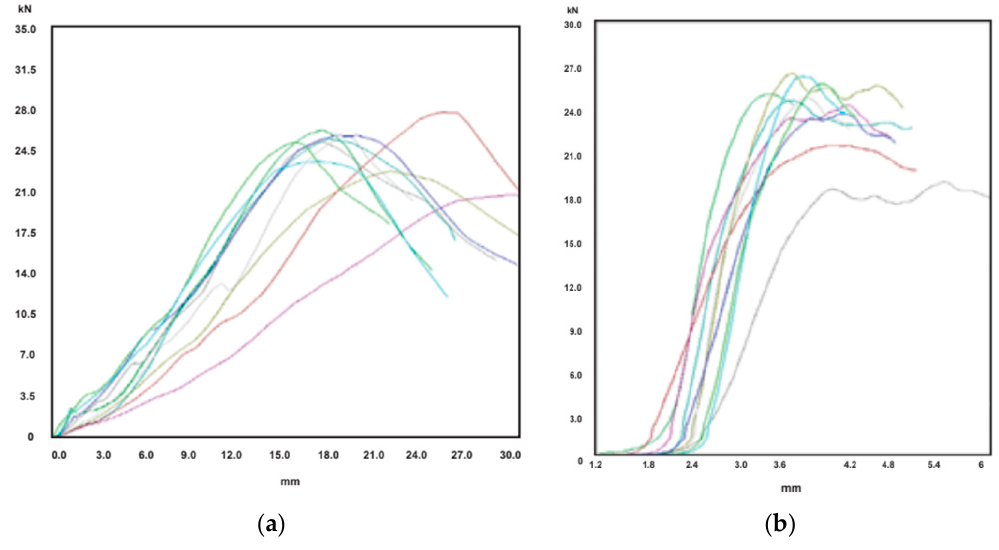
Figure 5. Force-displacement curves of the tests of the item E-09: ( a ) BCT test curves; ( b ) ECT test curves.